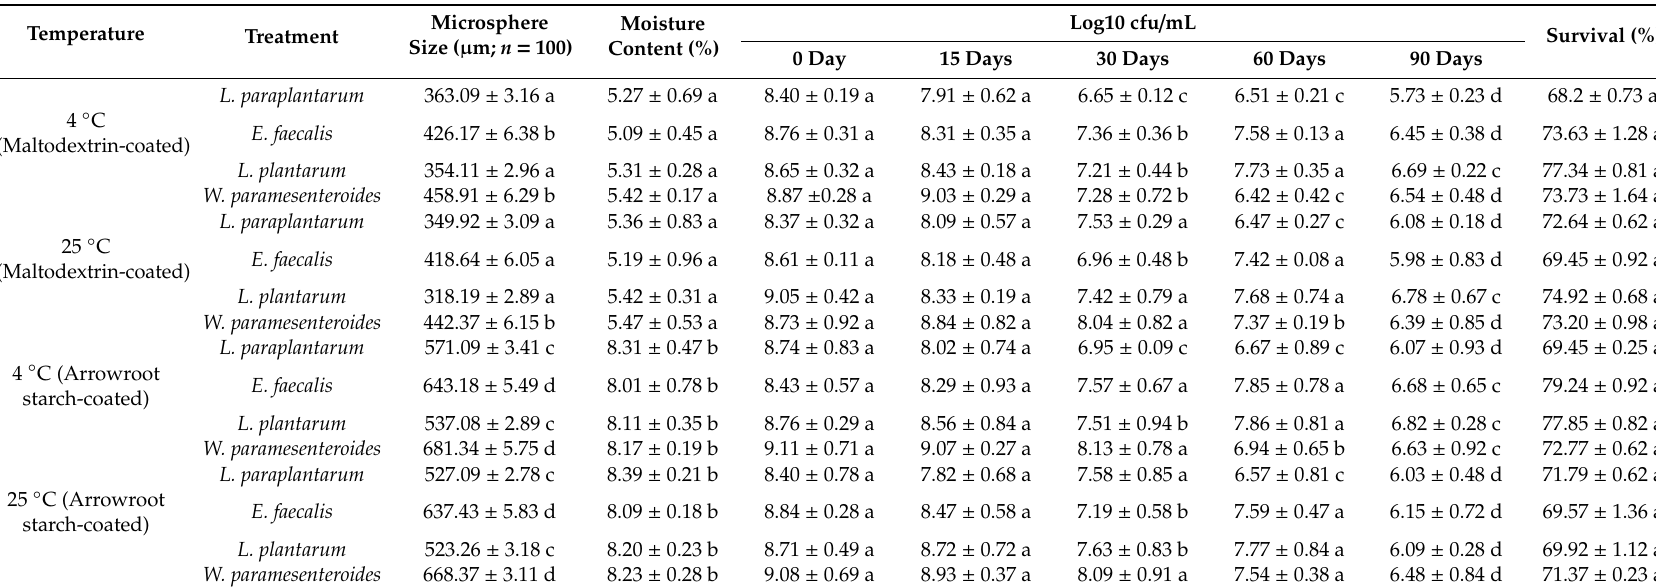
Table 3. Viability of encapsulated arrowroot and maltodextrin combined probiotics L. paraplantarum , L. plantarum , W. paramesenteroides , and E. faecalis (log10 cfu / mL) 1 in yoghurt during storage for 3 months at 4 and 25 ◦